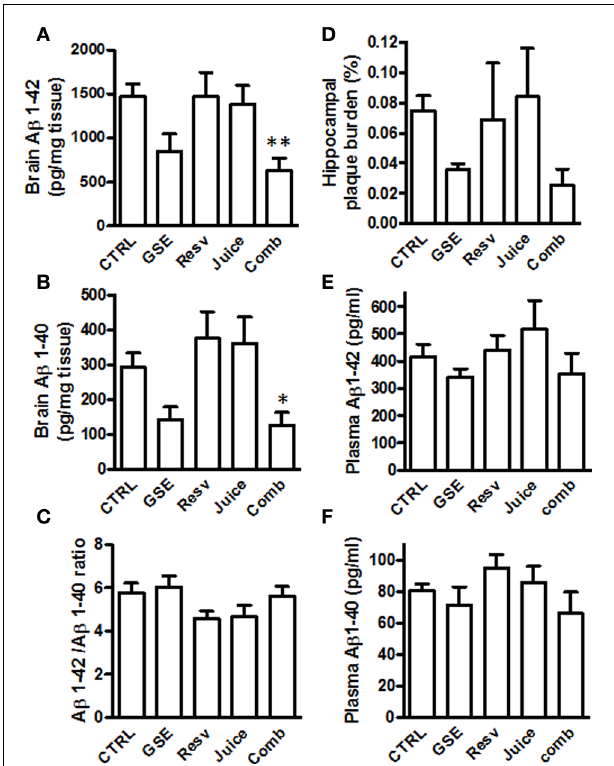
FIGURE 4 | Chronic Comb treatment reduces brain neuropathology in J20 mice (A,B) Quantification of total A β 1 − 42 and A β 1 − 40 in the brains of GSE-, Resv-, Juice-, Comb-treated, or CTRL mice by ELISA measurements (C) The ratio of A β 1 − 42 to A β 1 − 40 in the brains of GSE-, Resv-, Juice-, Comb-treated, or CTRL mice. (D) Assessment of plaque burden (percentage of area covered by plaques) in the hippocampus of the J20 mice following chronic treatment. (E,F) Assessment of plasma levels of amyloid peptides by ELISA. Data represents mean ± s.e.m., n = 8 − 9 per